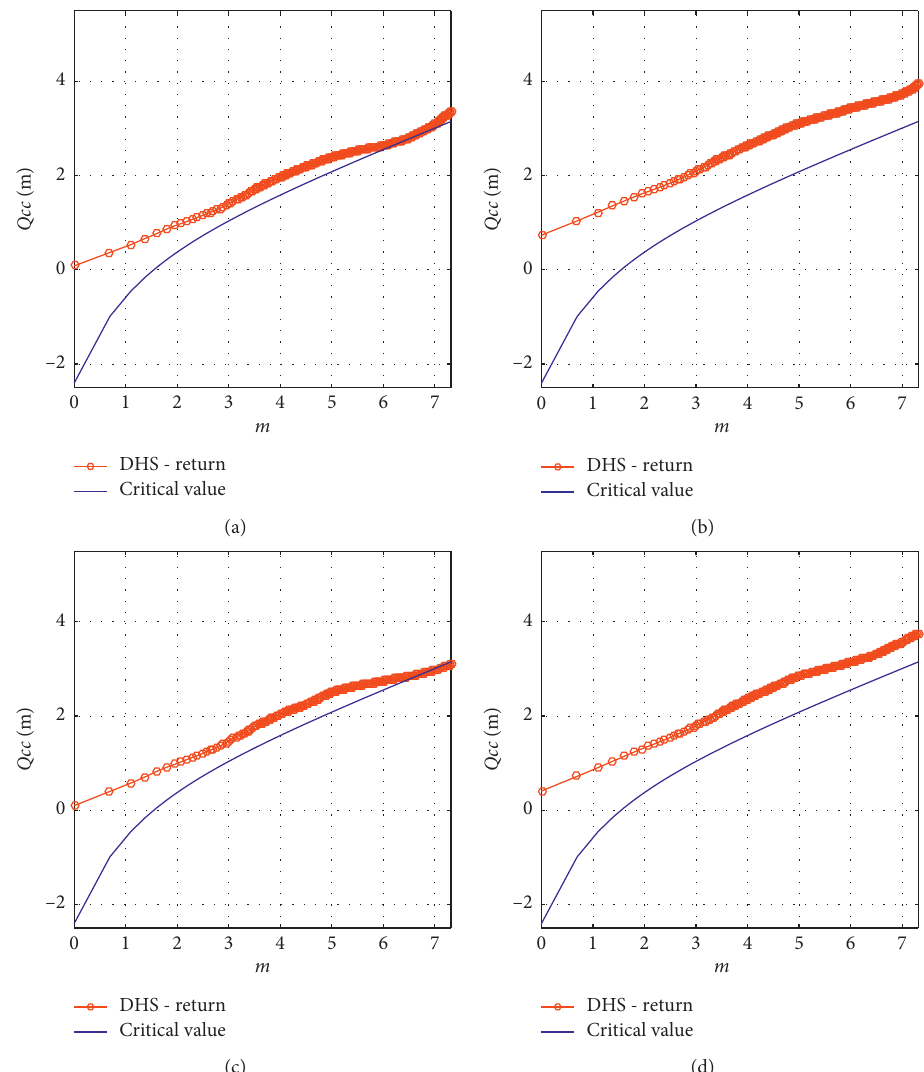
Figure 3: The cross-correlation statistics between online sentiment (DHS) and stock market return in developing countries: (a) Brazil: BVSP, (b) Indonesia: JKSE, (c) Mexico: MXX, and (d) India: